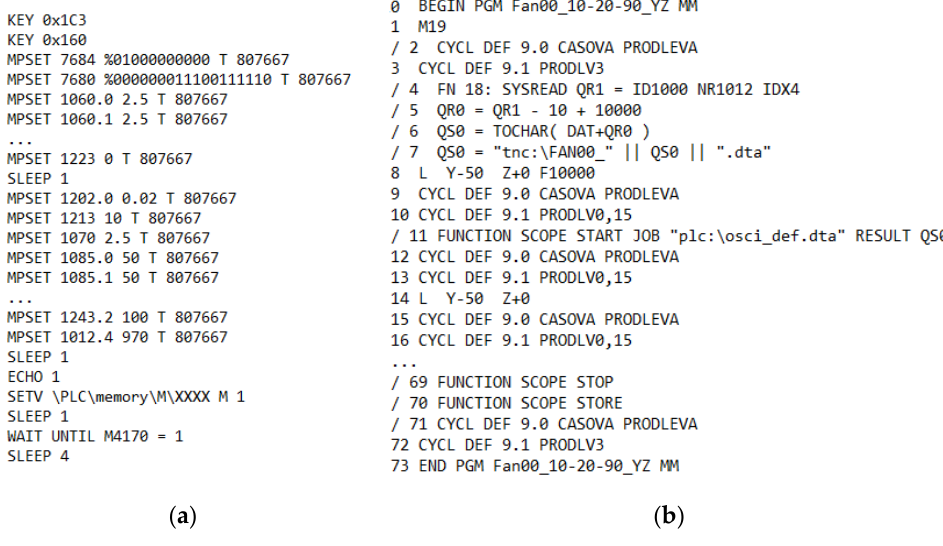
Figure 8. ( a ) A segment of the TNCcmd batch file specifying the parameter combinations of one specific test by setting the values of the interpolator parameter in memory with the use of the MPSET function. ( b ) NC code used to run the part program as well as start, end, and save in the internal oscilloscope records.